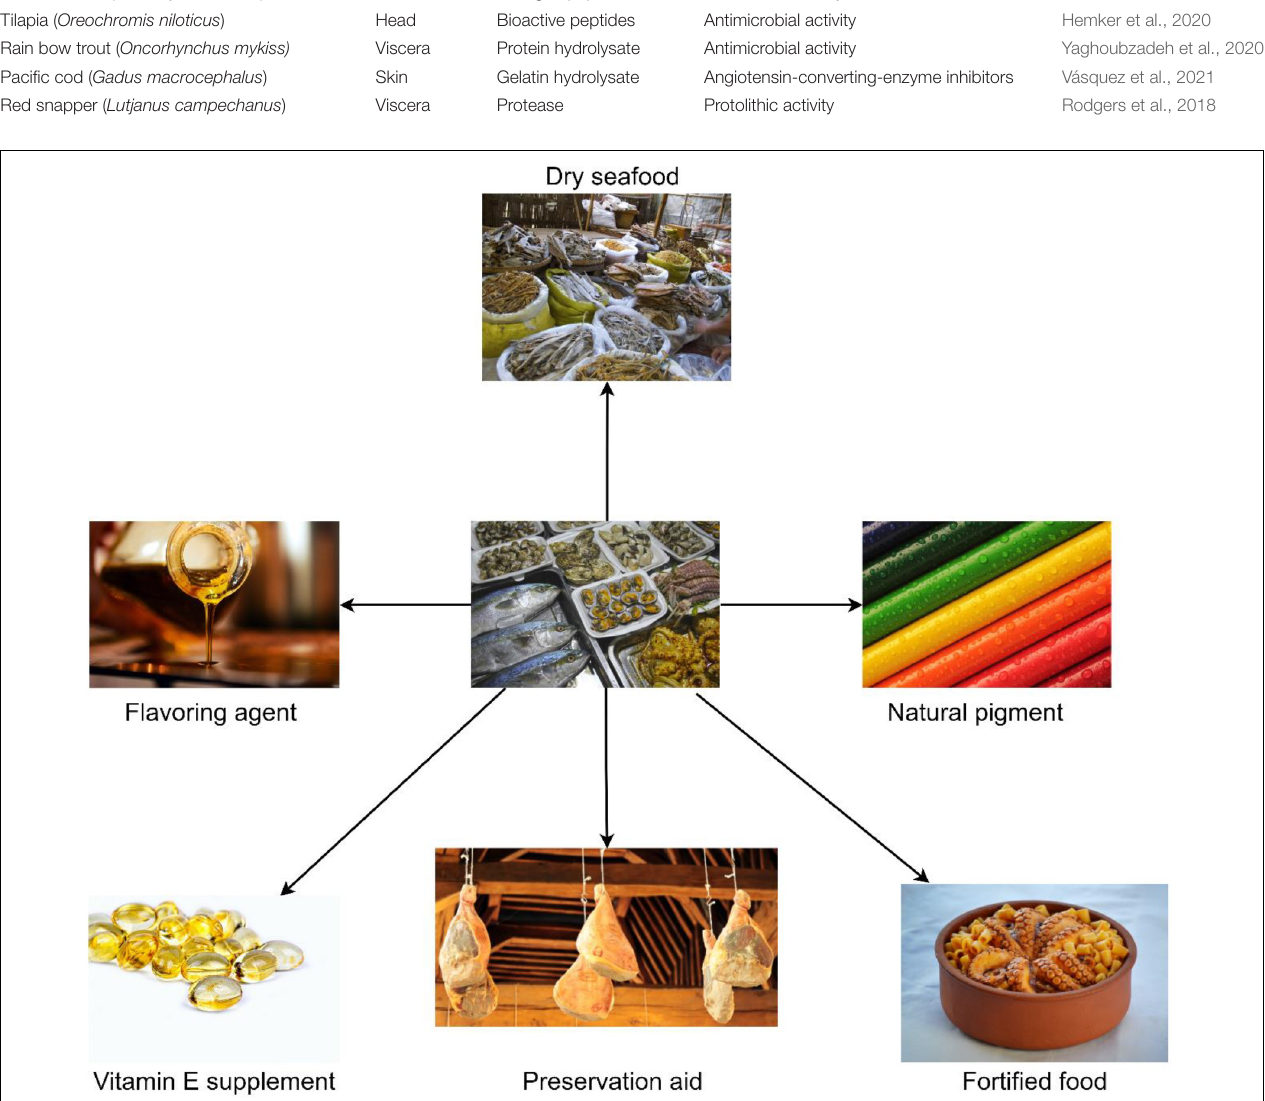
FIGURE 4 | Biomolecules derived from seafood as a functional food ingredient.